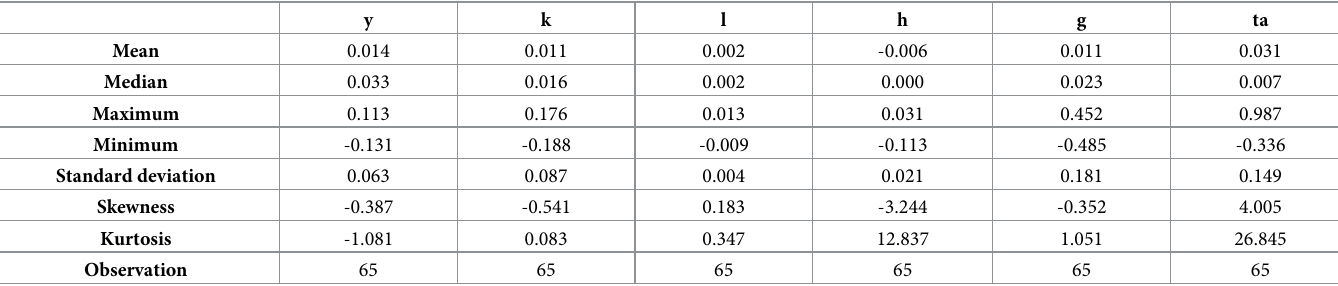
Table 1. Descriptive statistics for the whole data set.